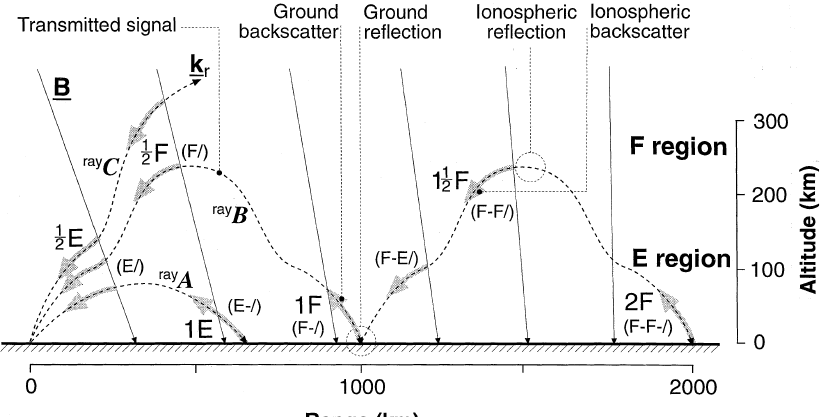
Fig. 1. A schematic diagram of some of the possible propagation modes and regions from which backscatter can occur. Mode nomen- clature in parentheses follows Davies (1967). Ranges and altitudes are approximate and depend on ionospheric conditions. Three rays are illustrated: A E region mode; B F region mode producing far-range as well as near- range backscatter; C a ray that penetrates